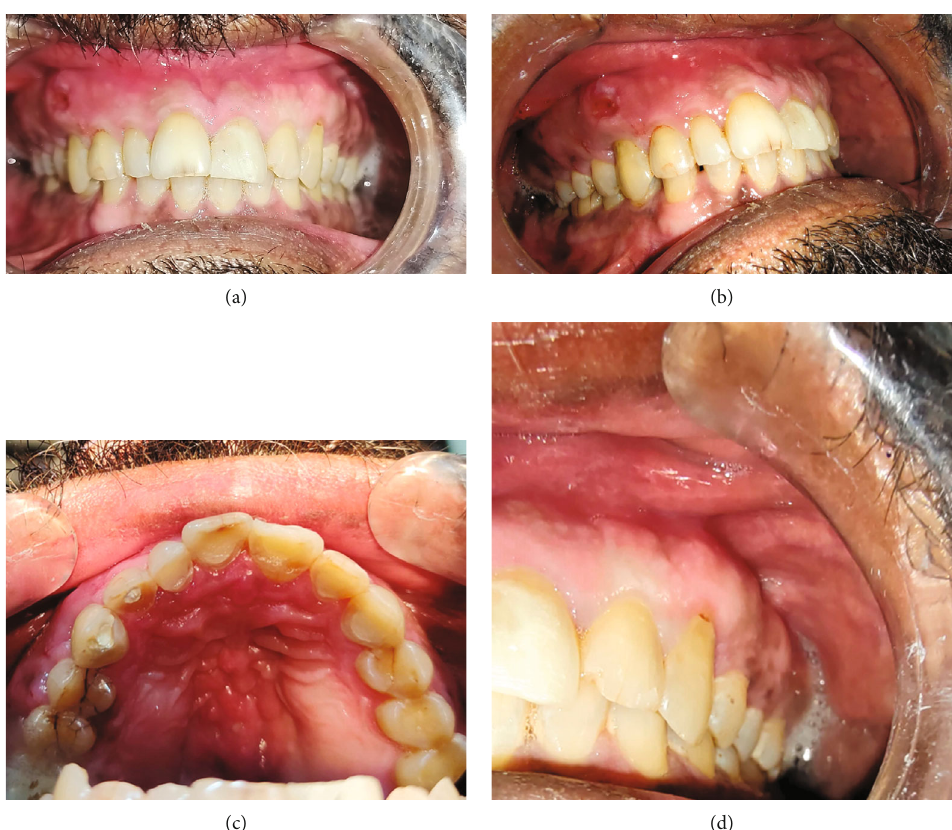
Figure 1: Clinical photographs of case 1: (a) frontal view, (b) right maxillary view showing the ulcer, (c) palatal view, and (d) right maxillary view showing normal gingiva.